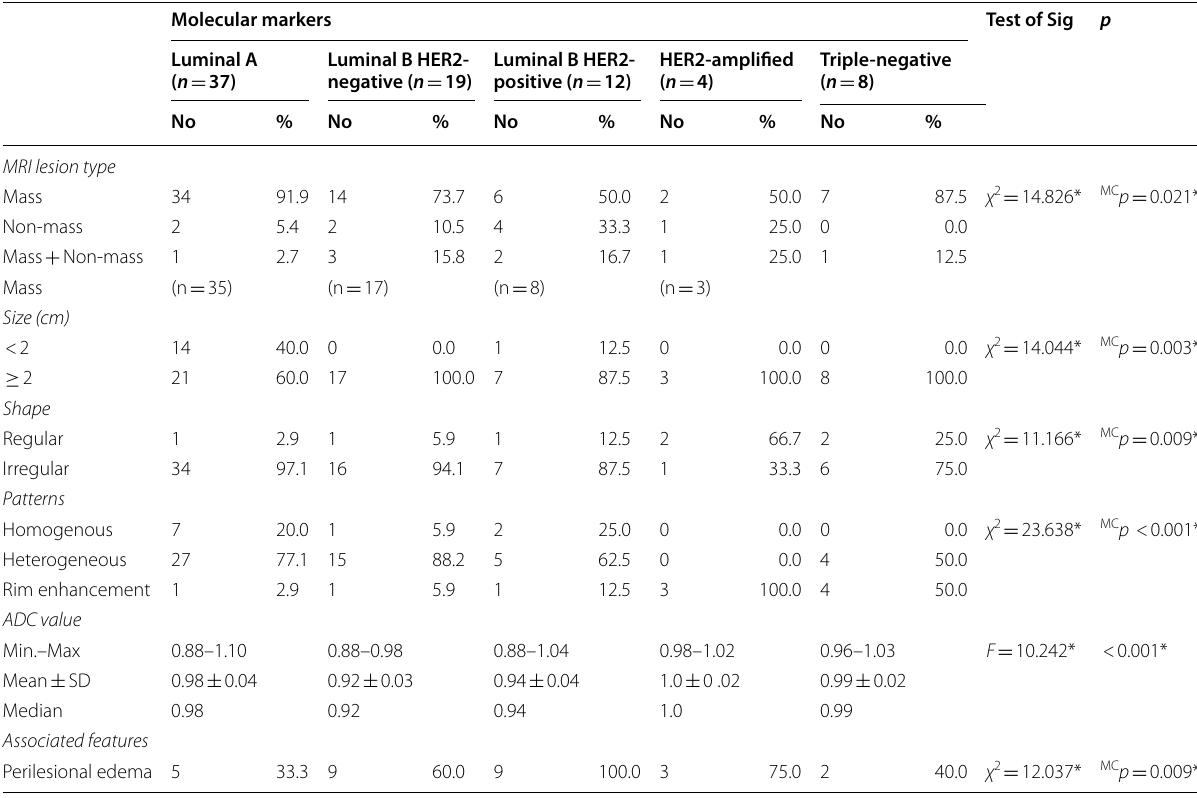
Table 7 The molecular markers statistically significant correlations with MRI features Molecular markers Test of